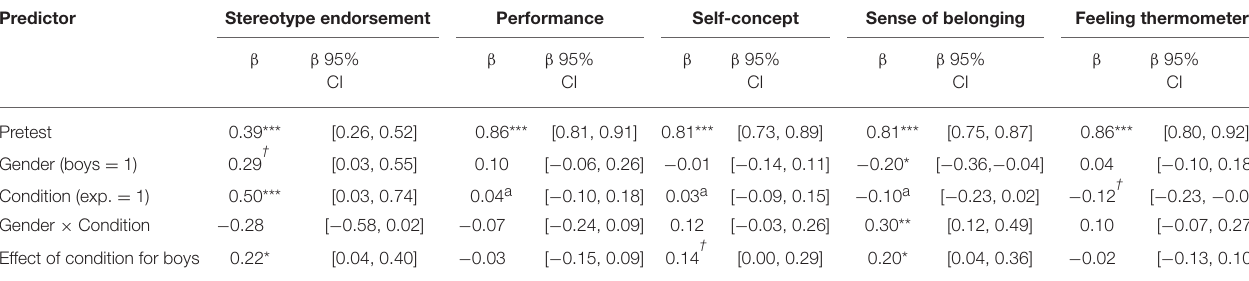
TABLE 5 | Multiple regression models 1: effects on stereotype endorsement, performance, self-concept, sense of belonging, and feeling thermometer. Predictor